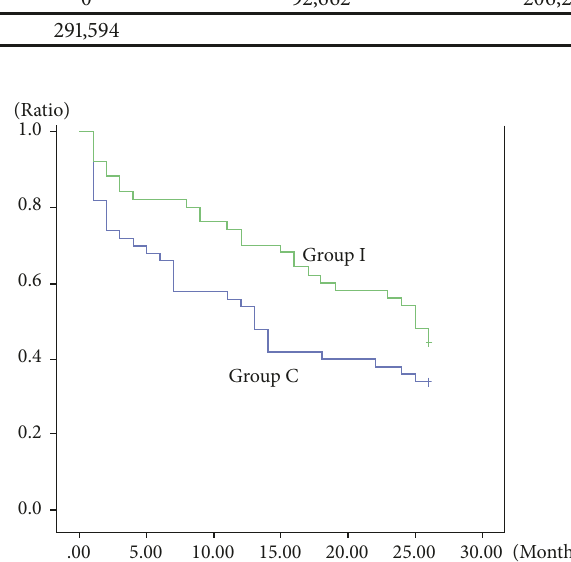
Figure 3: Outpatient consultation ratio of the metabolic-related diseases in Groups I and C. (Kaplan-Meier